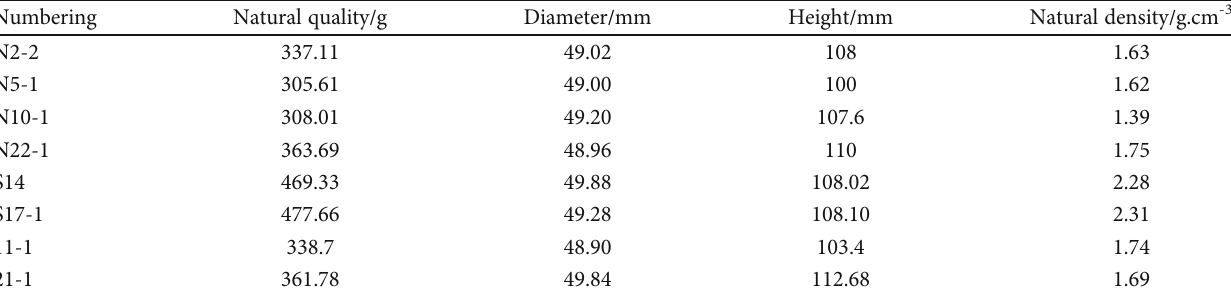
Table 6: Basic parameters of the